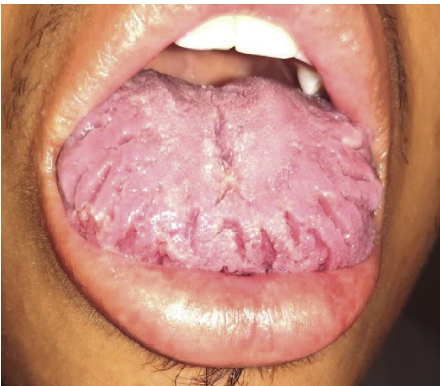
Figure 1: Slight labial edema and a scrotal or fissured